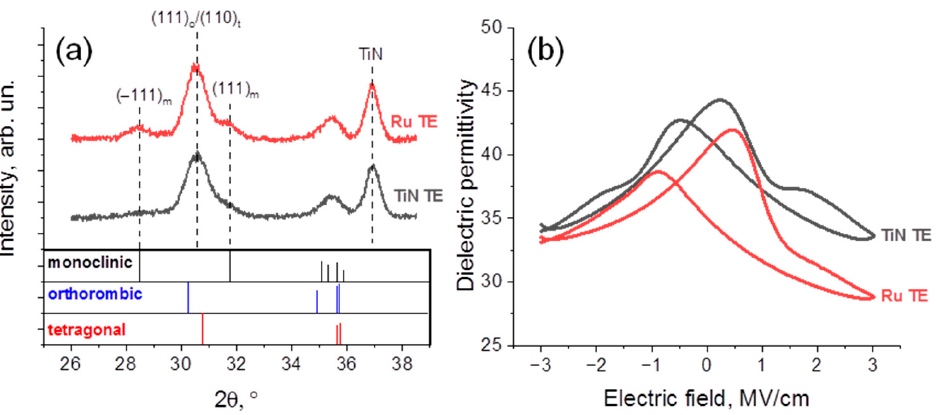
Figure 1. ( a ) GIXRD for HZO-based capacitors with TiN and Ru TE with reference patterns reported for m-, o- and t-phases of HZO [1]. ( b ) k vs. applied electric field dependences obtained from the small-signal C-V measurements performed at the pristine state for HZO-based capacitors with TiN and Ru TE.